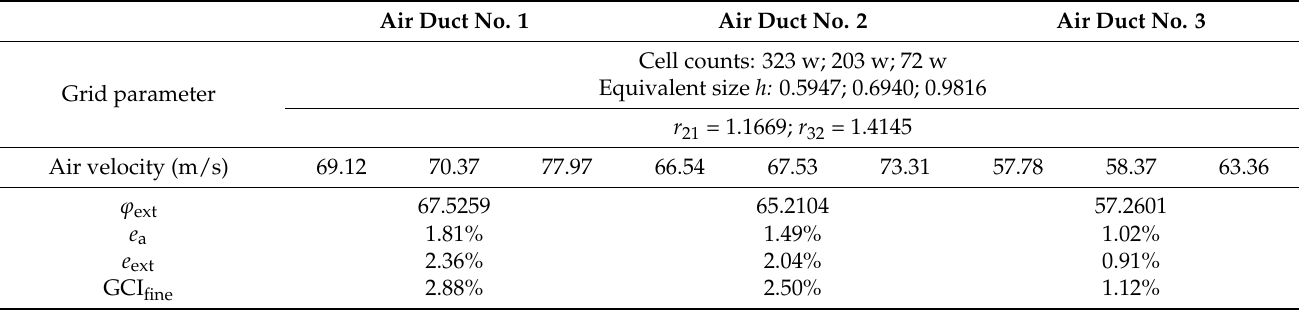
Table 2. Examination of grid convergence.